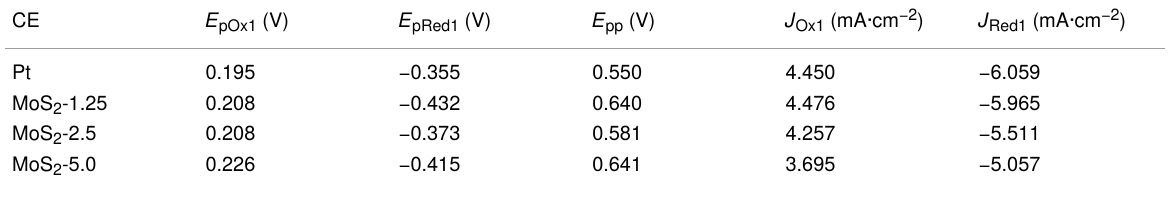
film in the back reaction at the TiO 2 /electrolyte interface (TiO 2 /dye/electrolyte). EIS data were fitted using an equivalent- circuit model including the series resistances of electrolyte and FTO substrate ( R s ) and the charge-transfer resistances on the CE/electrolyte and TiO 2 /dye/electrolyte interfaces ( R ct1 and R ct2 ) associated with the corresponding constant phase ele- ments (CPE1 and CPE2) as described in Figure 6 (Figure 6, insert).